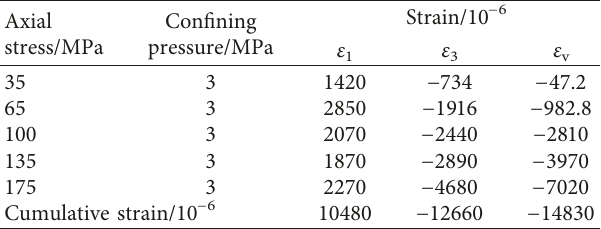
Table 2: The sandstone’s strain